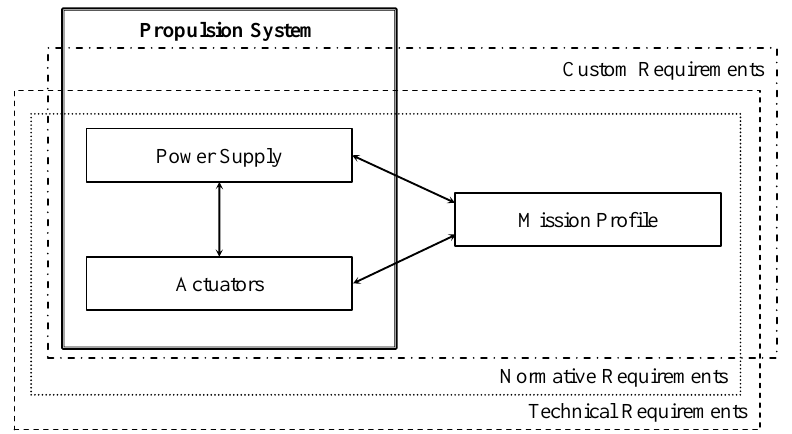
Figure 3. Schematic of the integrated functional design framework: the propulsion system is modeled as the set of the power supply and actuator sub-systems, interacting each other and with the mission profile module. All the blocks are affected by constraints imposed by technical, normative framework- related, or custom